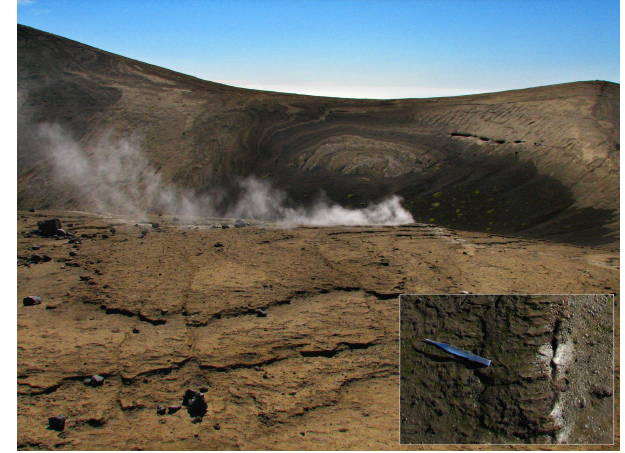
Figure 6. Fumaroles on Surtsey on the western palagonite ridge. The inserted photo shows a close-up of a fumarole, with tweez- ers for size comparison. Very few bryophytes, mostly Bryum ar- genteum , were found in this habitat, and then near the fumaroles or in narrow cracks in rock that had cooled off. Photos: GVI, 10 July